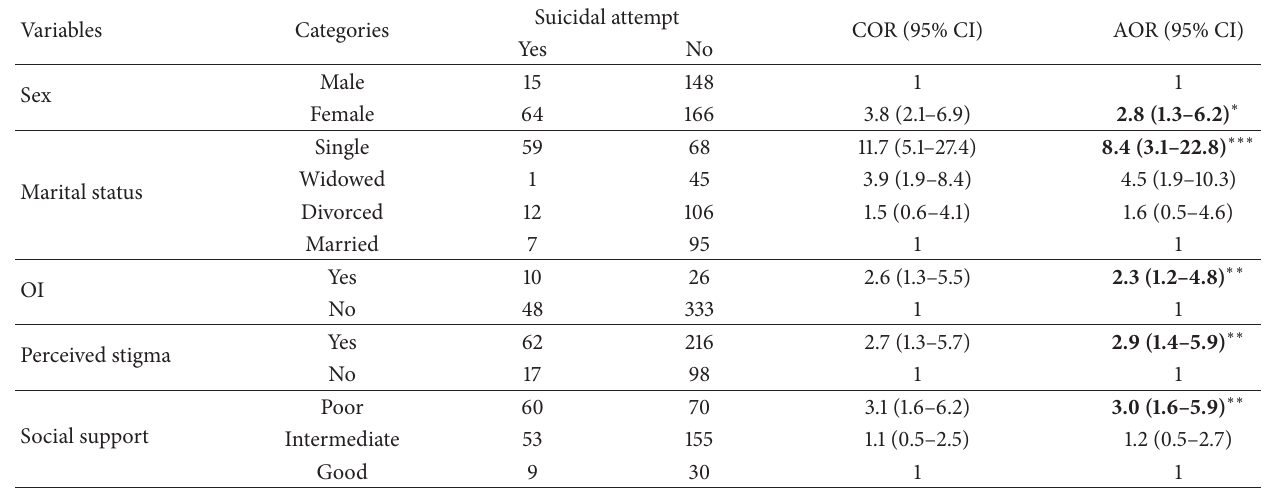
Table 6: Factors associated with suicidal attempt of participants at Debark Hospital Northwest, Ethiopia, 2015.